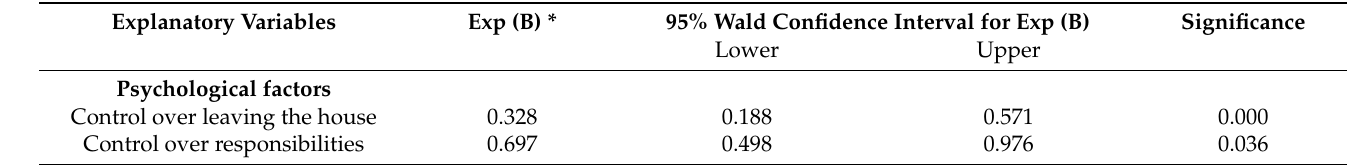
Table 4. Results of logistic regression for significant explanatory variables, with binary outcome variable of non-adherence or adherence to SI rules (own